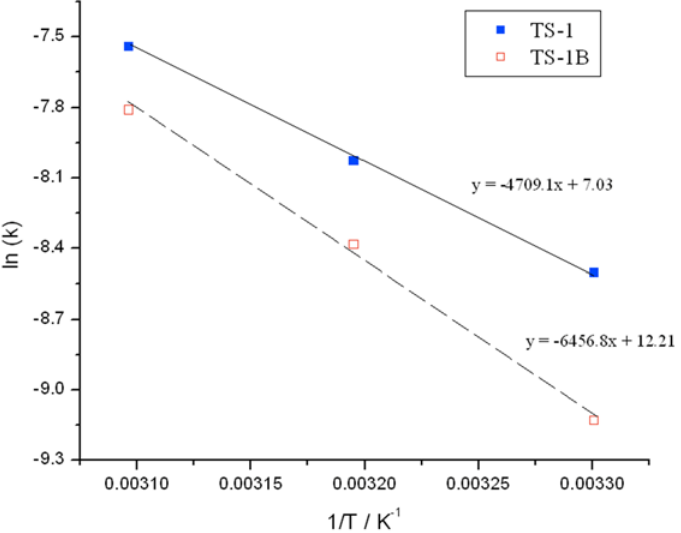
Figure 3. Arrhenius plots obtained for (blue squares) TS-1 and (hollow red squares) TS-1B.